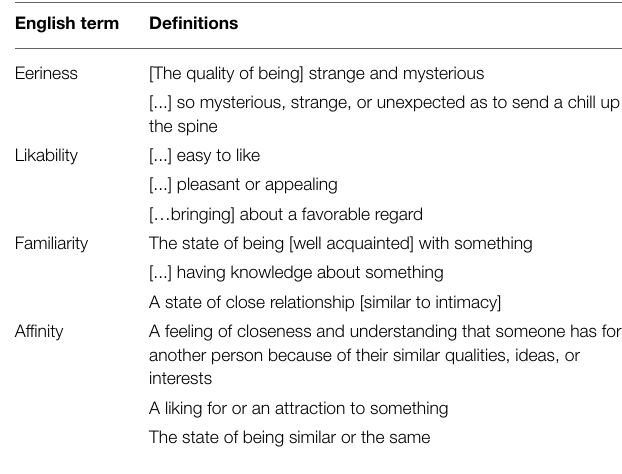
TABLE 2 | Dictionary definitions for the common English translations of Mori’s affinity